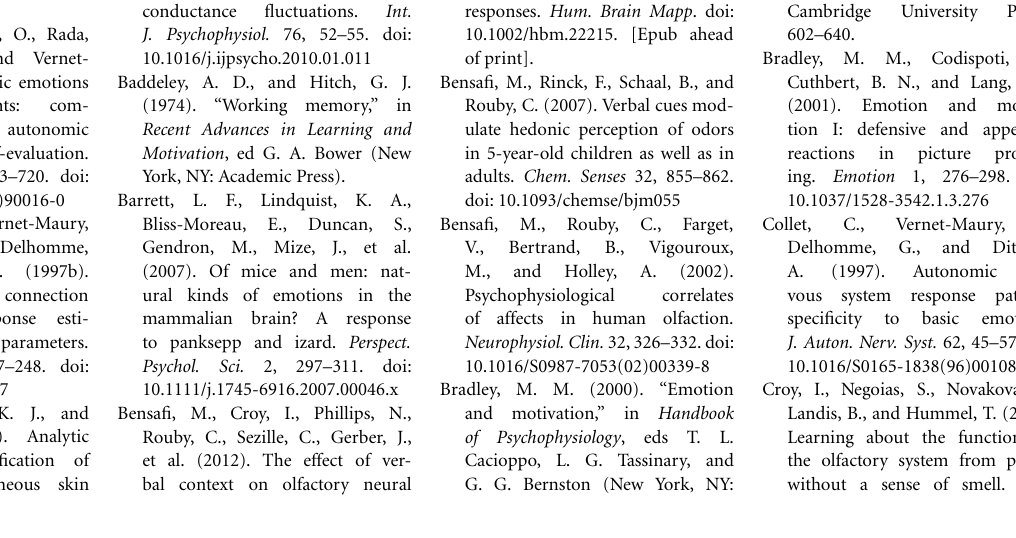
Table S1 | Effect of labeling on autonomic